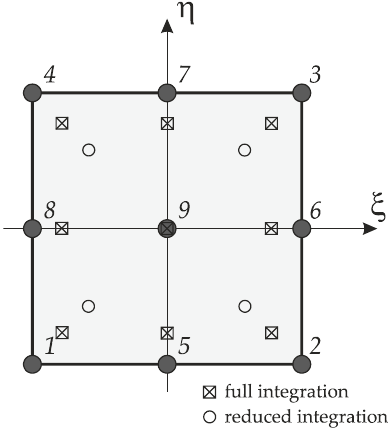
Figure 1. Nine-node quadratic Lagrange rectangular element.